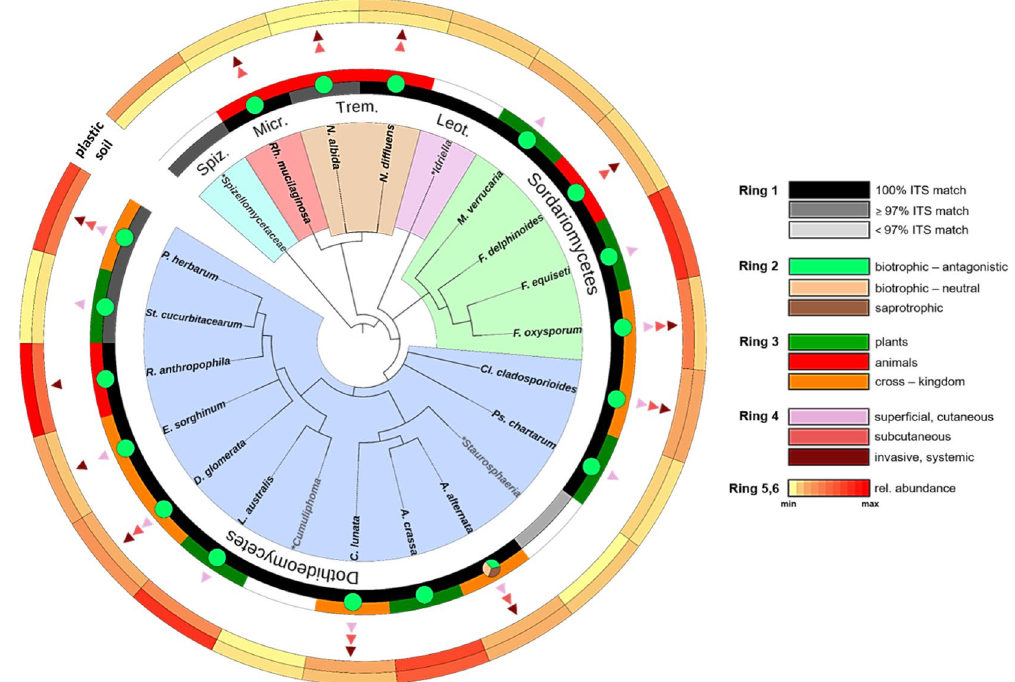
Figure 4. Phylogenetic distributions within the PCM. Displayed are those 22 OTUs accounting for ≥ 0.5% of plastisphere reads and contributing ≥ 0.3% to the plastic/soil dissimilarity based on SIMPER analysis with occurrence on MP in every site. OTUs classified at the species level (black font) were annotated with trait data. OTUs classified to at genus or higher level were not annotated (grey font). (*) indicates ‘unclassified’. Branch colours code for the indicated fungal classes, where Spiz. = Spizellomycetes, Micr. = Microbotryomycetes, Trem. = Tremellomycetes, Leot. = Leotiomycetes. Ring 1 indicates the success of OTU assignment based on the